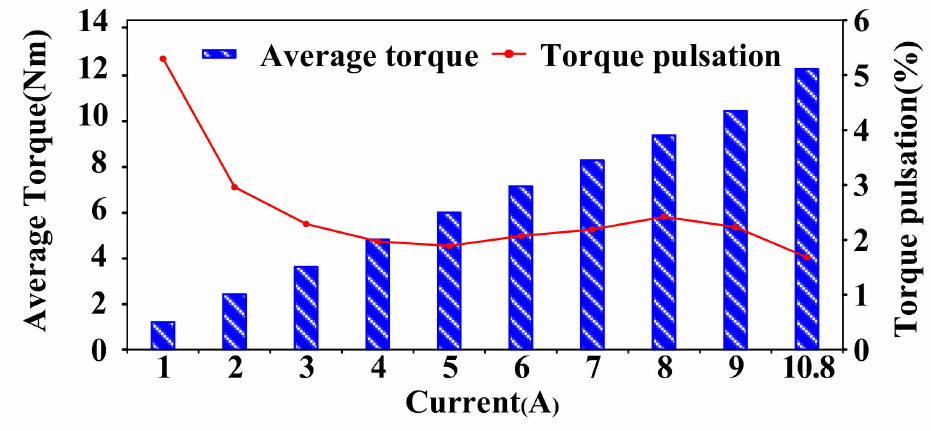
Figure 13. Average torque and torque pulsation vary with